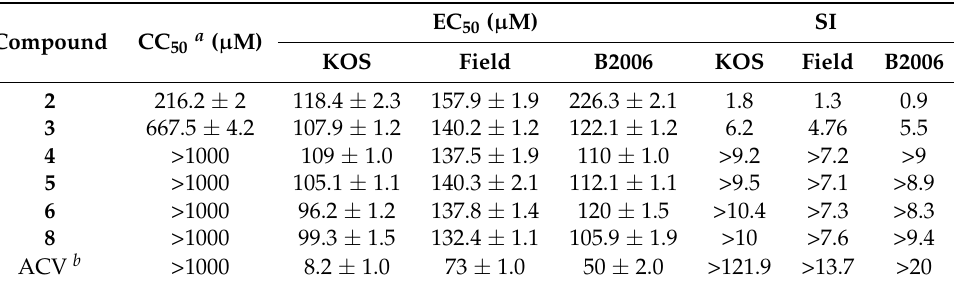
Table 2. Antiviral activity of hit compounds against wild-type and ACV-resistant HSV-1 strains. EC 50 s were calculated by nonlinear